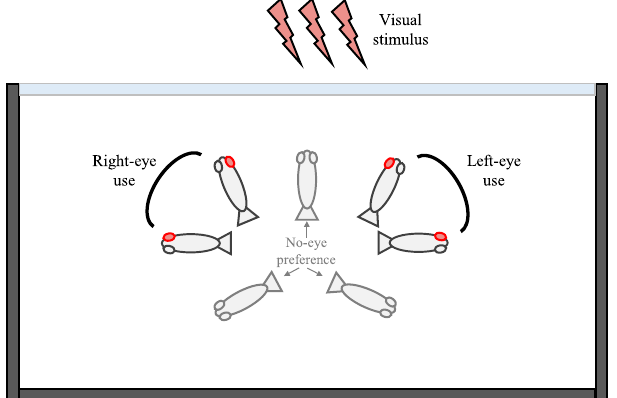
Figure 1. Schematic representation of the test apparatus for eye lateralization determination. The three dark gray walls represent the opaque wall of the aquarium, while the light blue wall corresponds to the transparent wall where the visual stimuli are presented. No eye preference was recorded when the fish was perpendicular to the transparent wall ( i.e . binocular stimulation) or when it formed an angle larger than 180° with respect to the transparent wall ( i.e . fish looking in the opposite direction).